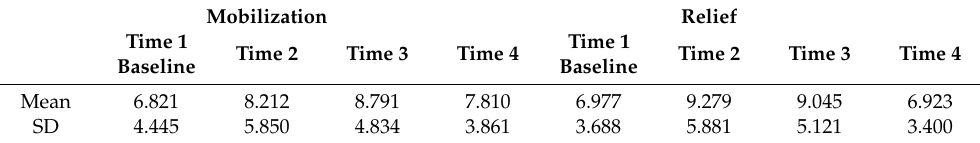
Table 1. Descriptive Statistics of Cortisol Concentrations (nmo/L) Under Four Blocks in Two Conditions.